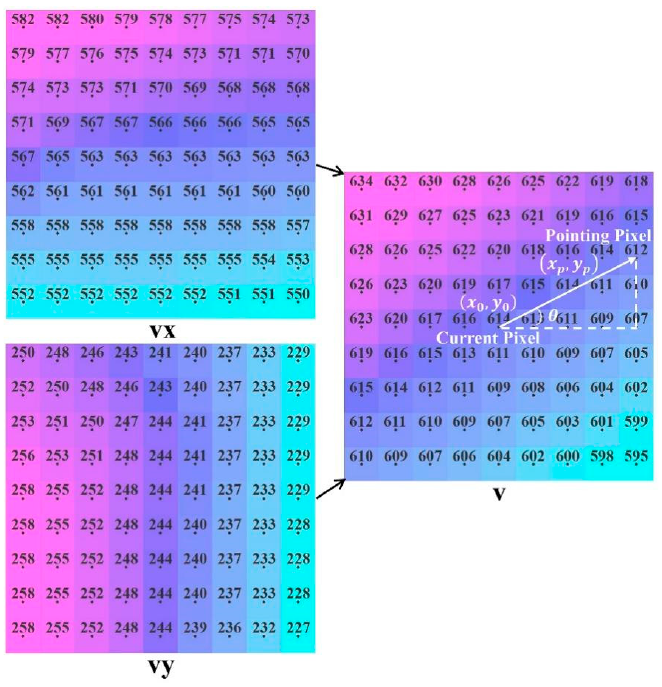
Figure 2. Diagram of Current pixel and Neighborhood pixel.